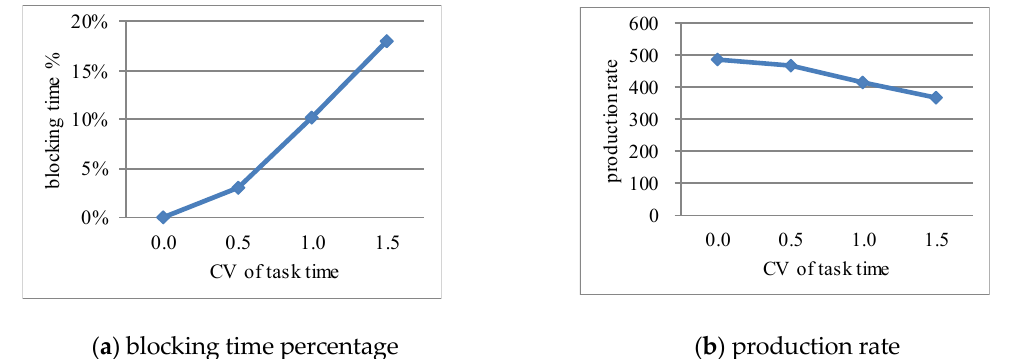
Figure 4. Effect of blocking over different assembly time variabilities in terms of ( a ) blocking time percentage over total assembly time and ( b ) production rate.